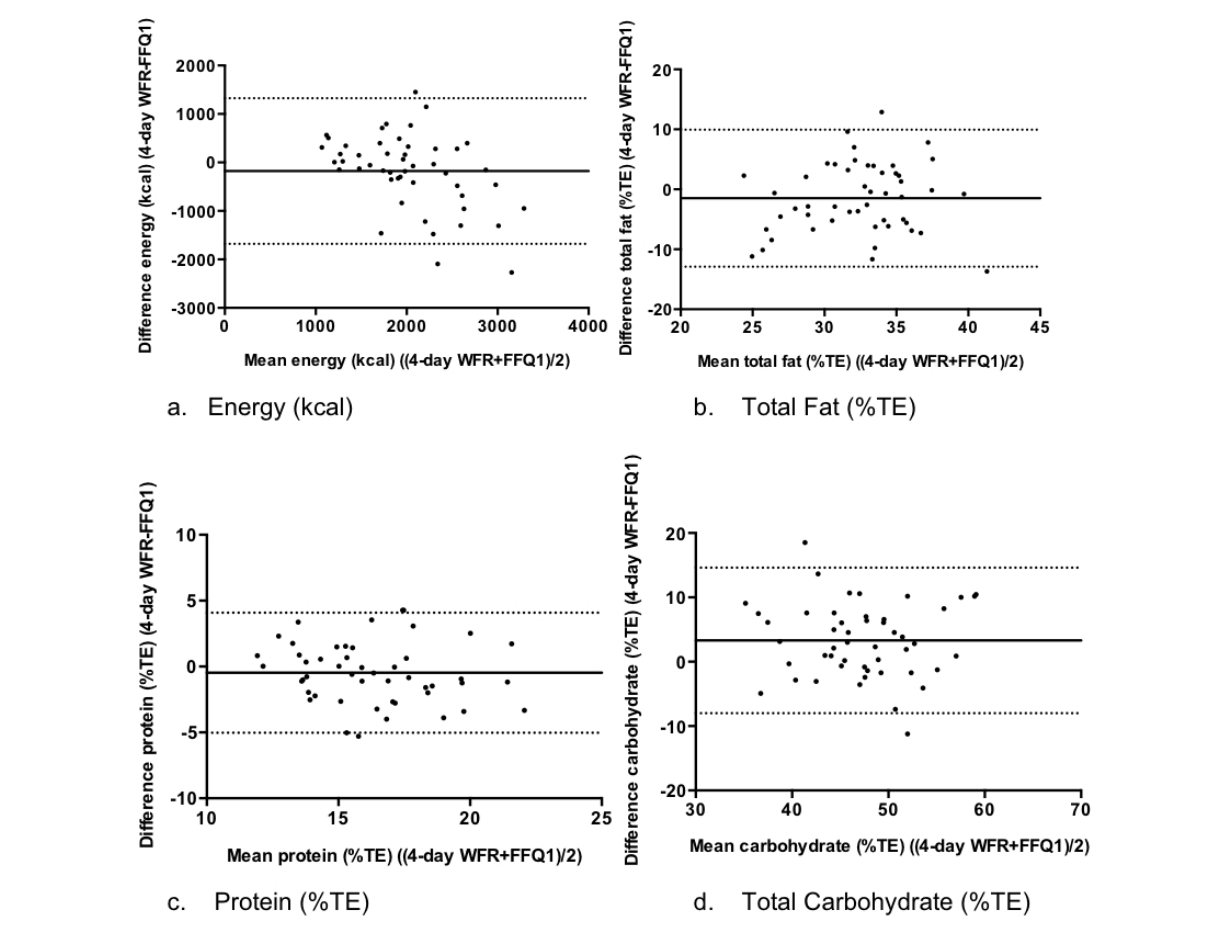
Figure 4. Validation study Bland-Altman plots for (a) energy, (b) total fat, (c) protein, and (d) carbohydrate with the mean difference and limits of agreement. The solid line represents the mean difference and the dotted lines represent the limits of